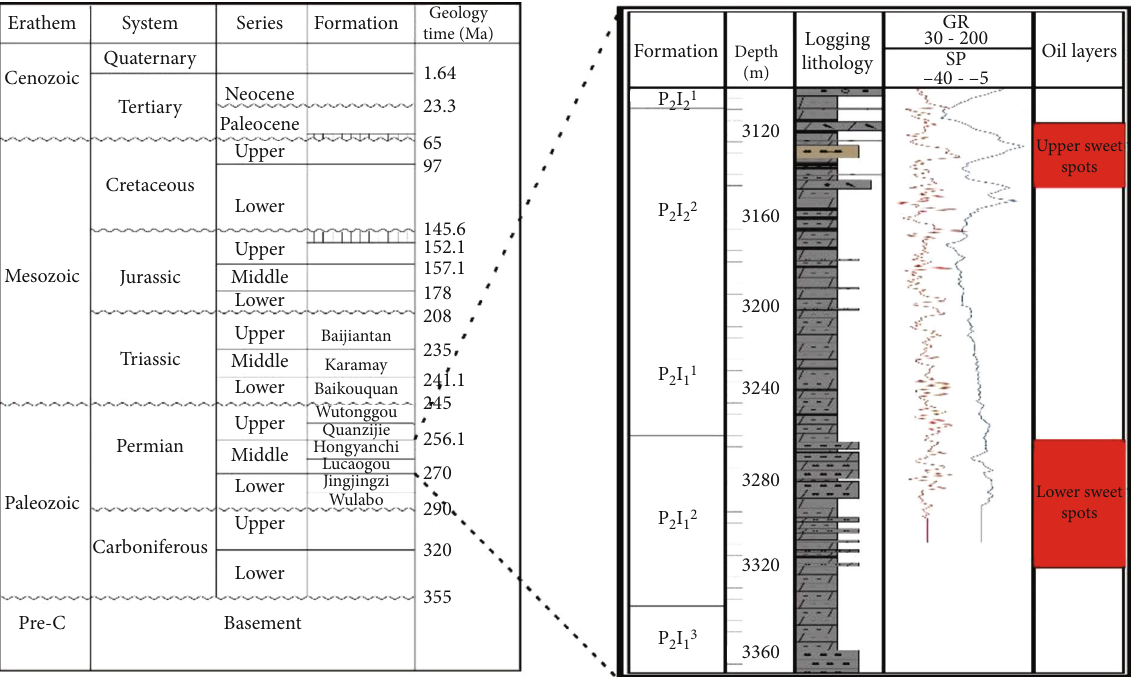
Figure 2: Stratigraphic column of the Lucaogou Formation in Jimusaer Sag.